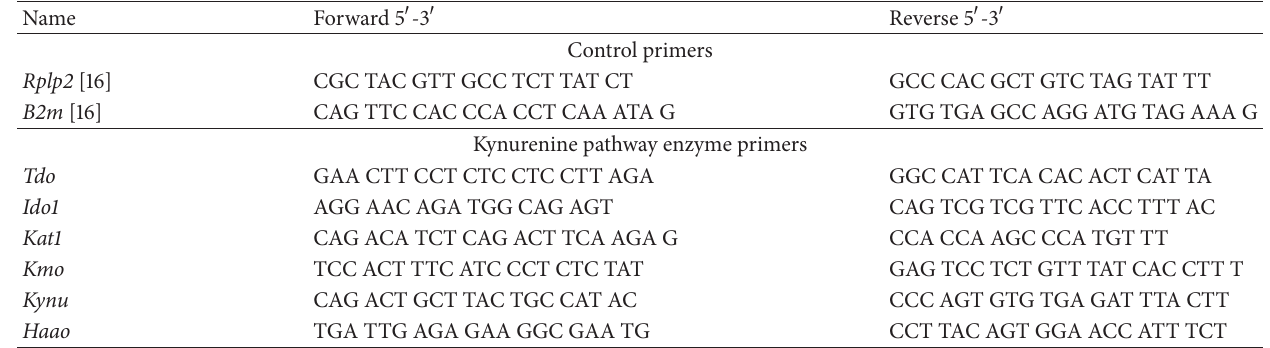
Table 1: Primer sequences used for control and kynurenine pathway